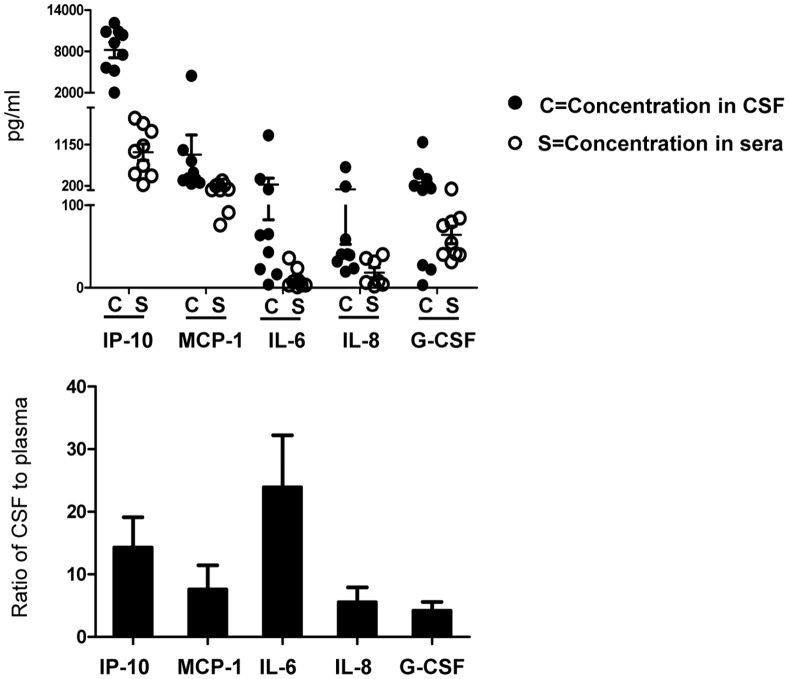
Five immune mediators are elevated in CSF as compared to plasma in EV71-positive patients with neurological complications.Cytokine/chemokine expression was evaluated in CSF samples from 9 severe patients with neurological manifestations. Five cytokines/chemokines levels were significantly higher in CSF as compared to plasma. Absolute cytokine/chemokine concentration in plasma (open circles) and CSF (solid circles) (upper panel); ratio of CSF:plasma concentrations >1 (lower panel). Data are expressed as mean ± SEM, and are representative of at least 2 experiments.